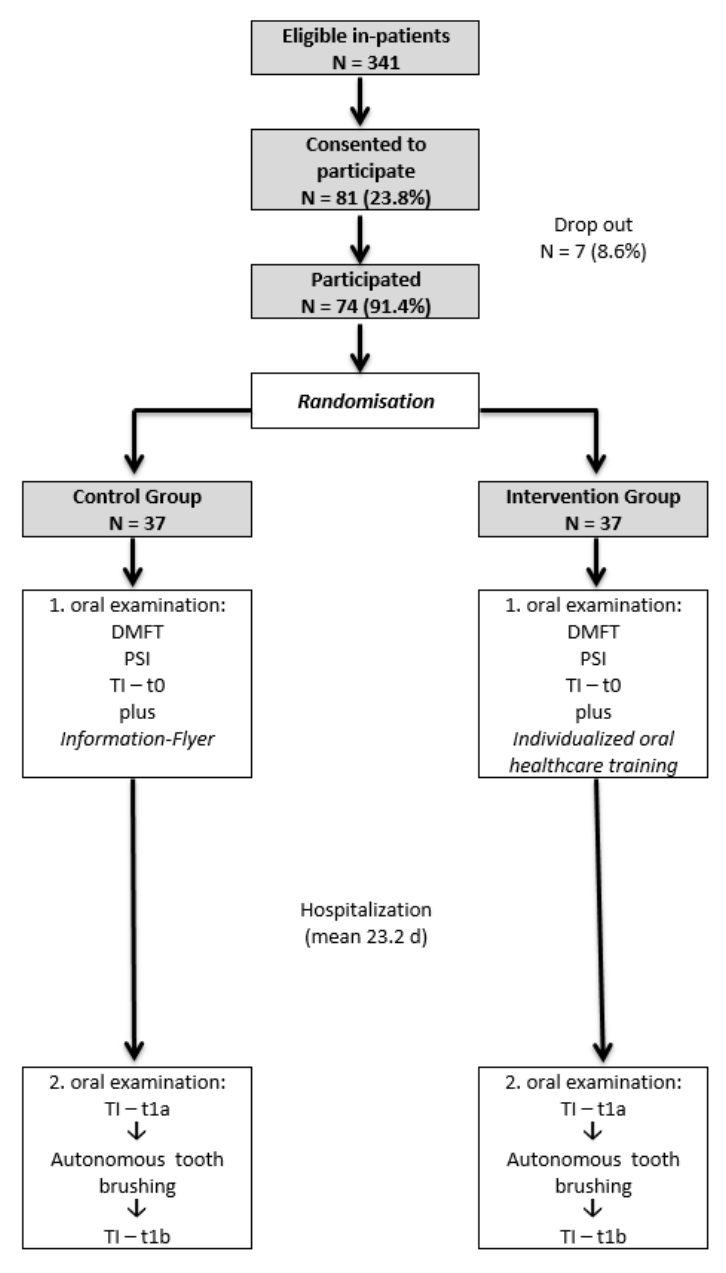
Figure 1. Study design.